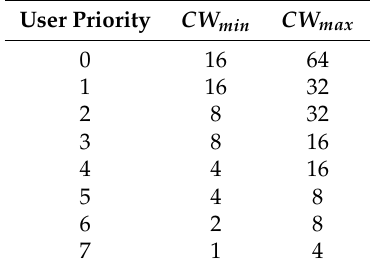
Table 4. Bounds for